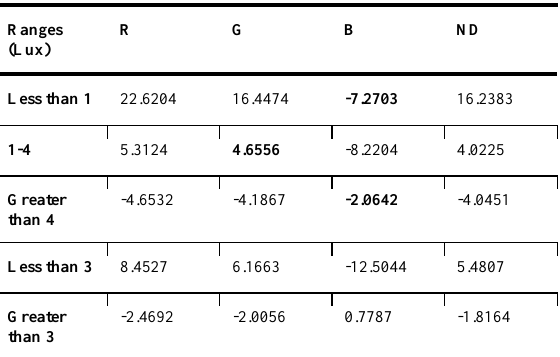
Table 7. Statistical comparison of P-bias per range of values